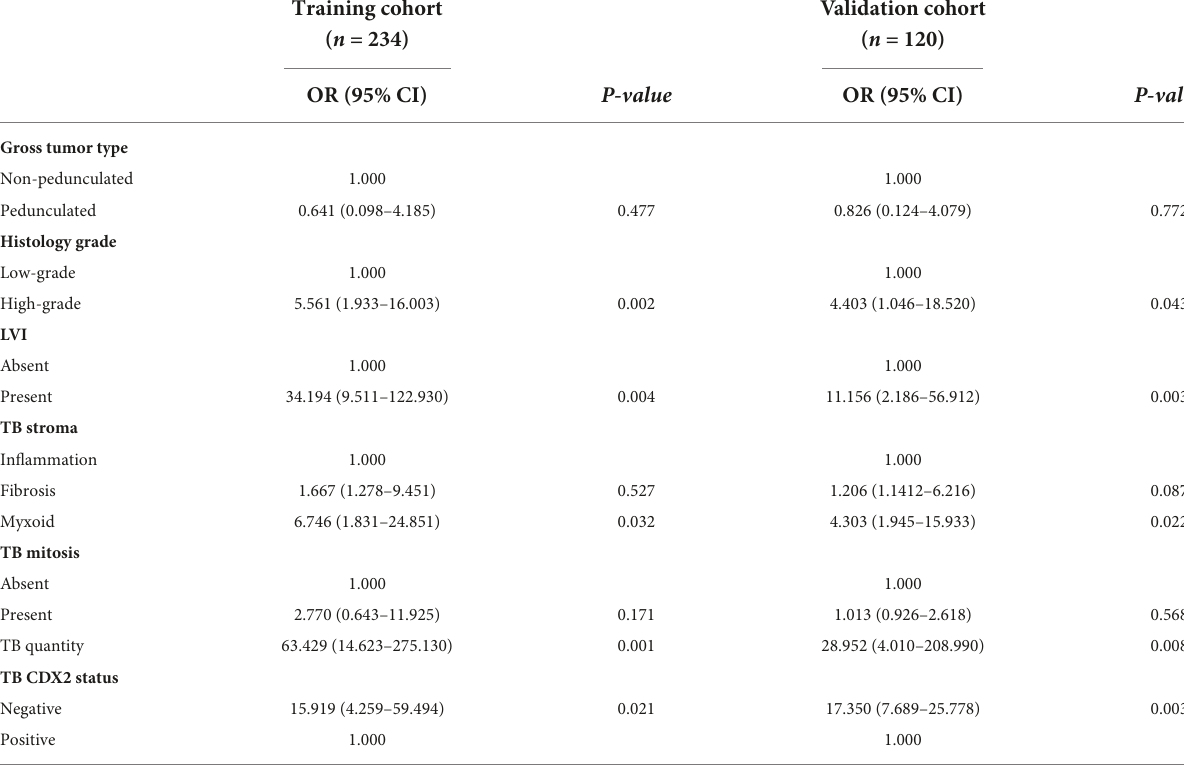
TABLE 2 Multivariate logistic regression analysis of lymph node